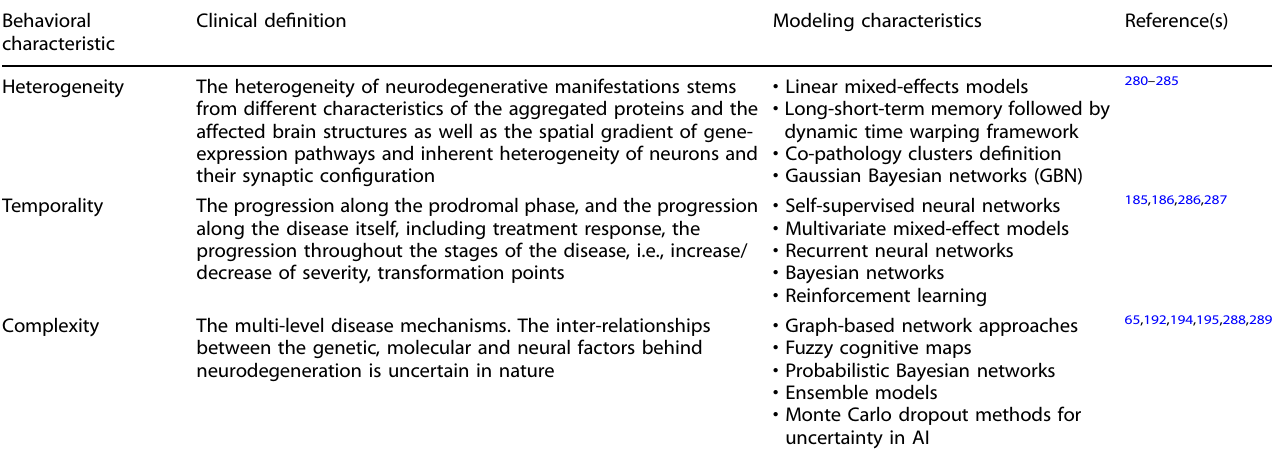
Table 2. Neurodegenerative behavior characteristics, their clinical de fi nition, modeling characteristics and corresponding relevant references. Behavioral